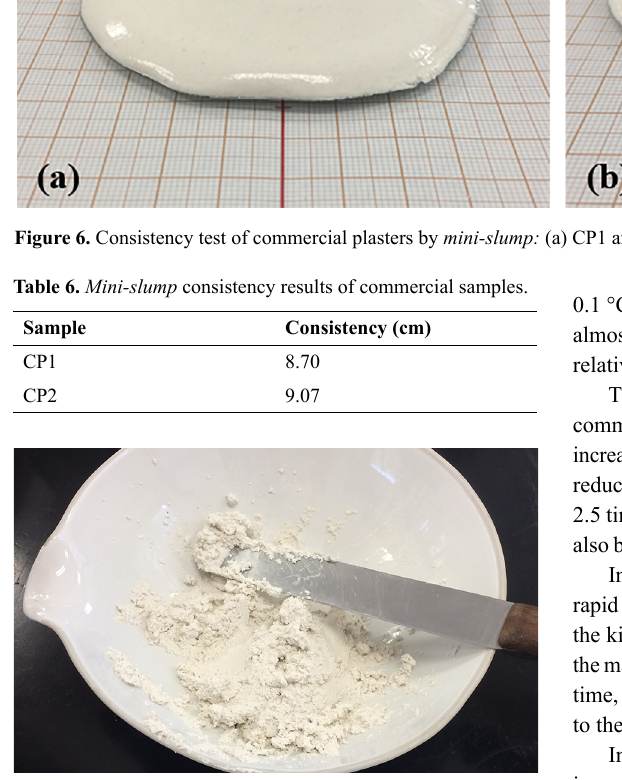
Figure 7. Freshly prepared RP1